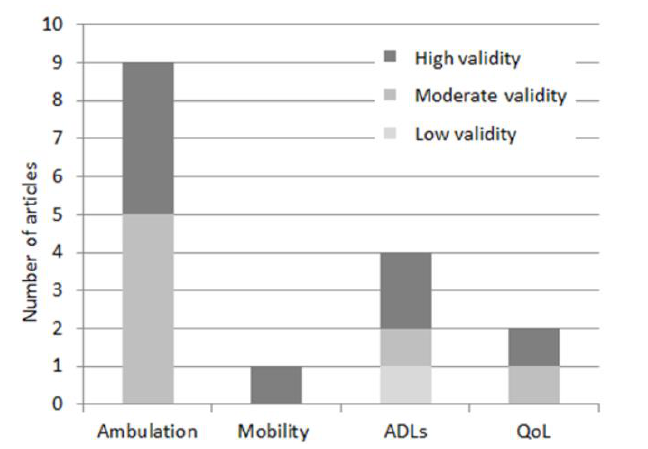
Figure 1. Number and quality of evidence across